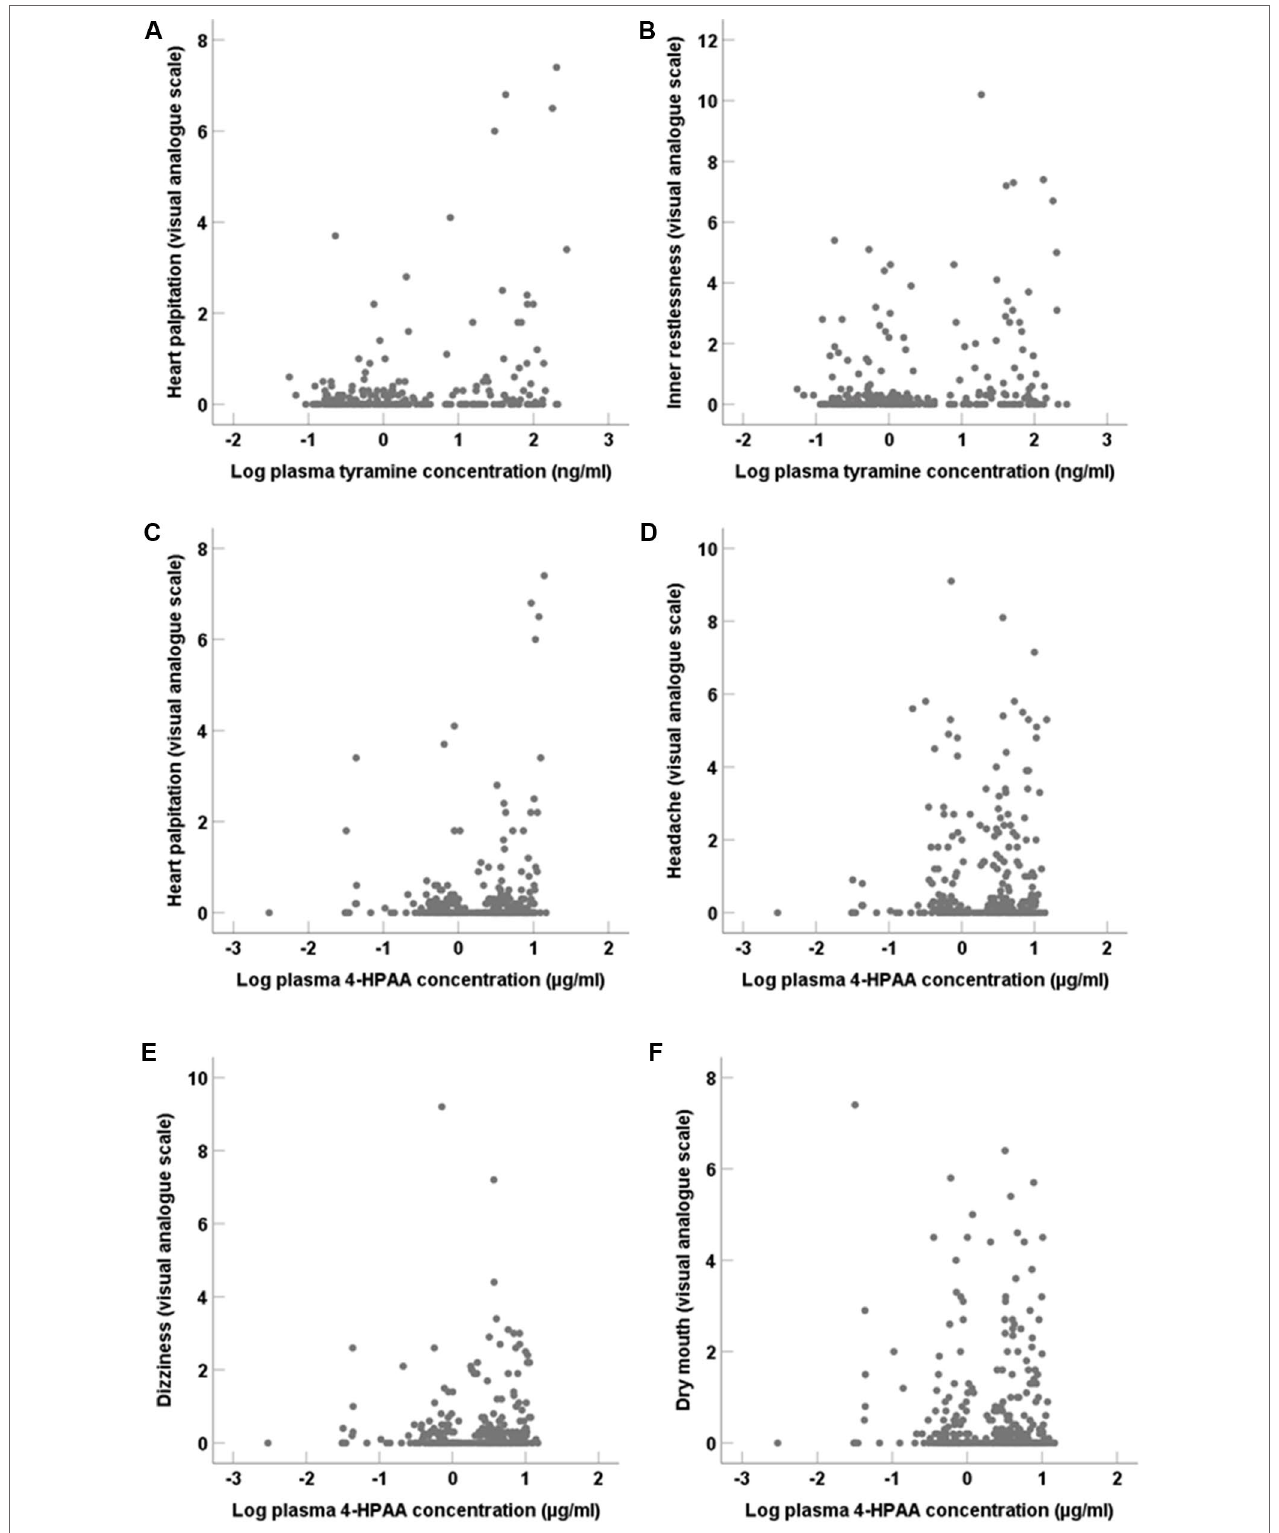
FigUre 8 | Adverse symptoms assessed by visual analogue scales in correlation (two-tailed) to systemic tyramine and 4-HPAA concentrations. (A) Heart palpitation (p < 0.001) and (B) Inner restlessness (p = 0.02) in correlation to tyramine. (C) Heart palpitation (p < 0.001), (D) headache (p = 0.01), (e) dizziness (p = 0.03), and (F) dry mouth (p = 0.049) in correlation to systemic 4-HPAA concentration.